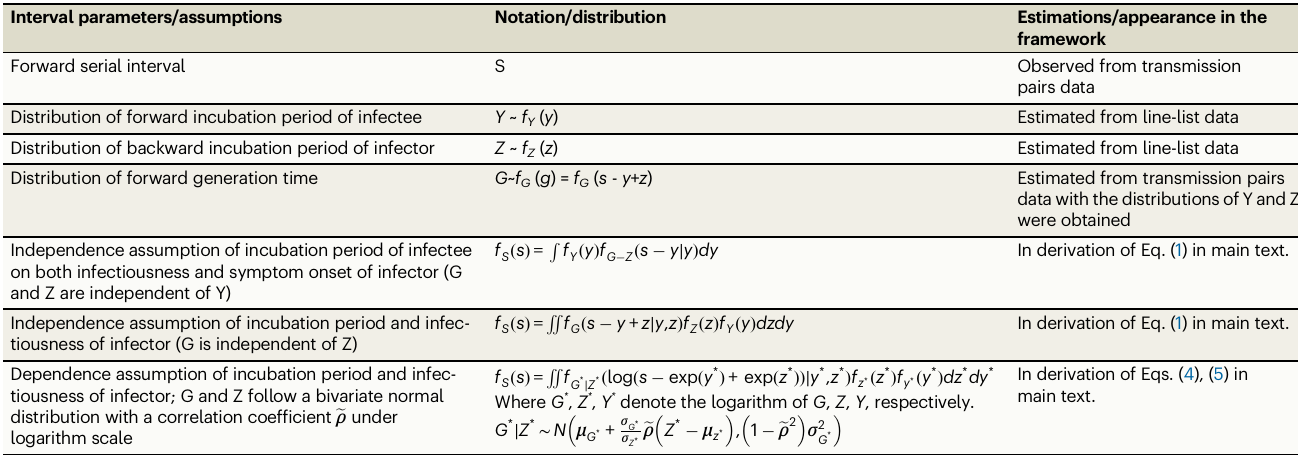
Table 1 | Summary of interval parameters, their distributions, and related assumptions in the inferential framework Interval parameters/assumptions